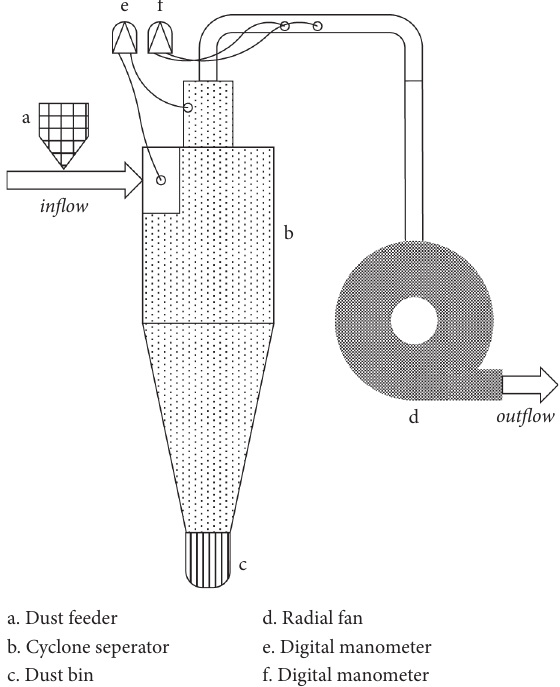
Figure 2: Schematic view of the lab-scale cyclone separator